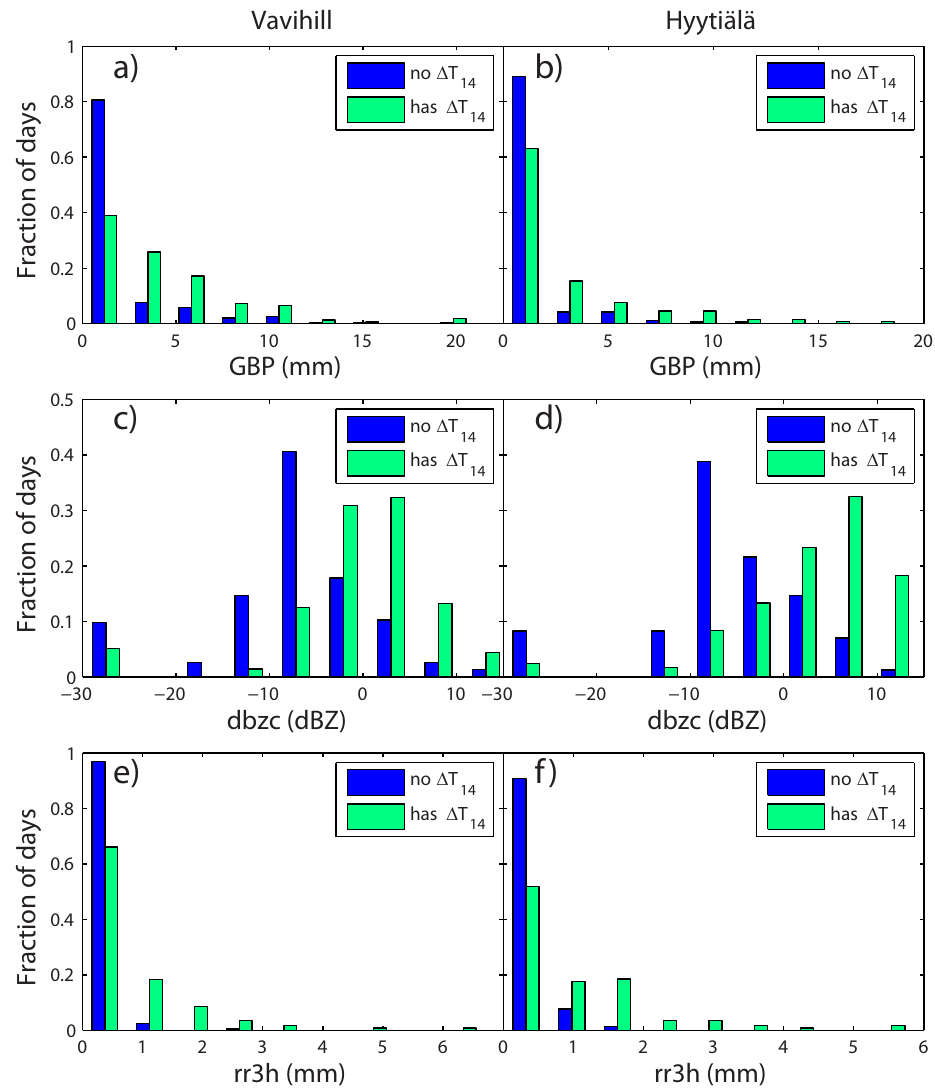
Fig. 7. Histograms of the amount of ground-based precipitation accumulated over 24 hours ( a and b ), reflectivity factor from ground-based weather radars (c and d) and the accumulated precipitation for a 3h period from the weather radars ( e and f ) for cases with profiles that reach 14µm (has 1T 14 ) and profiles that do not reach 14µm (no 1T 14 ). The figures on the left (a, c, e) are for the Vavihill dataset and (b, d, f) are for the Hyytiälä